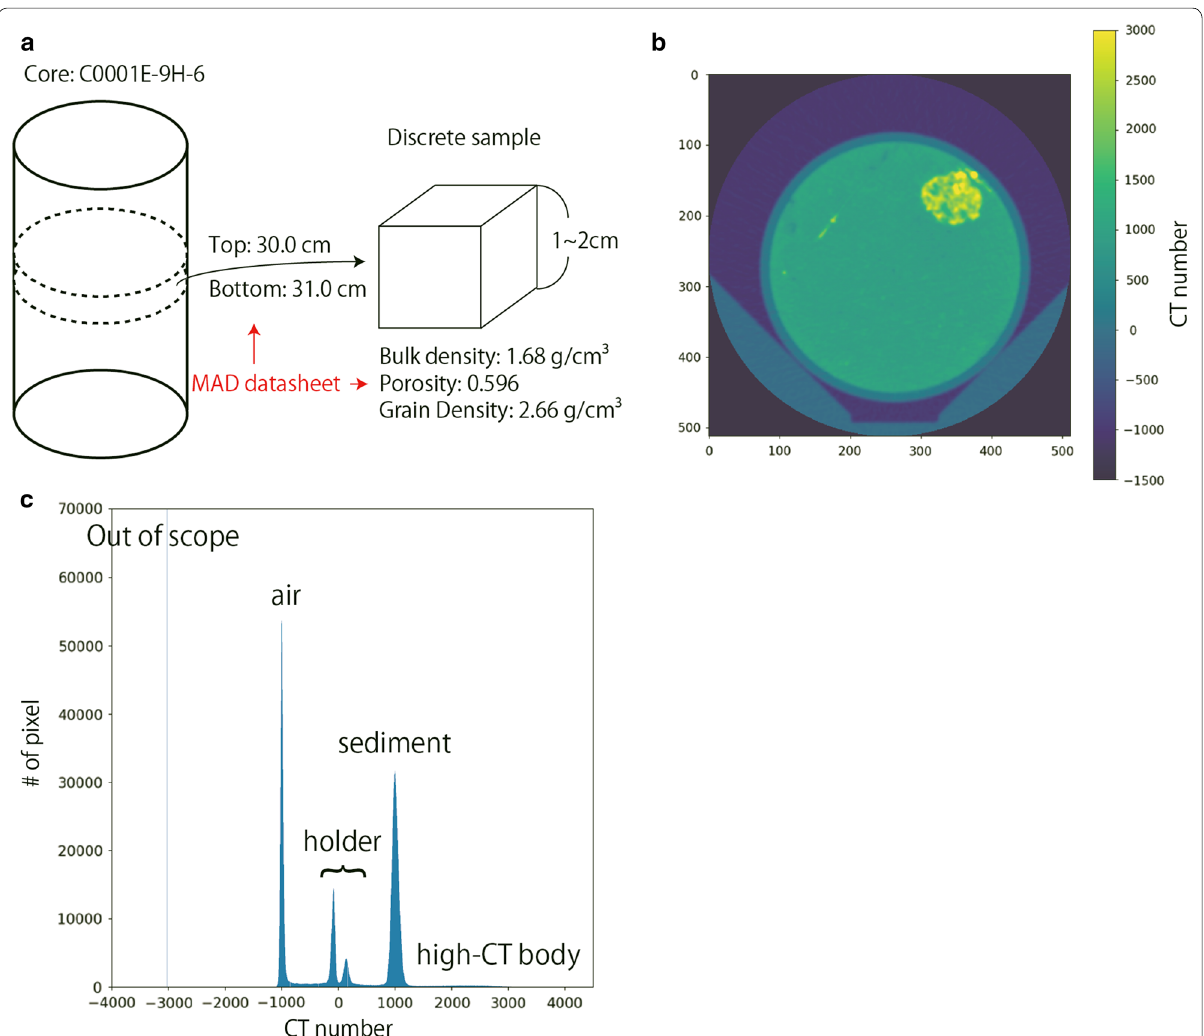
Fig. 3 XCT analysis example. a Schematic figure of moisture and density dataset. b Cross-section XCT image at C0001E c Histogram of CT numbers at this